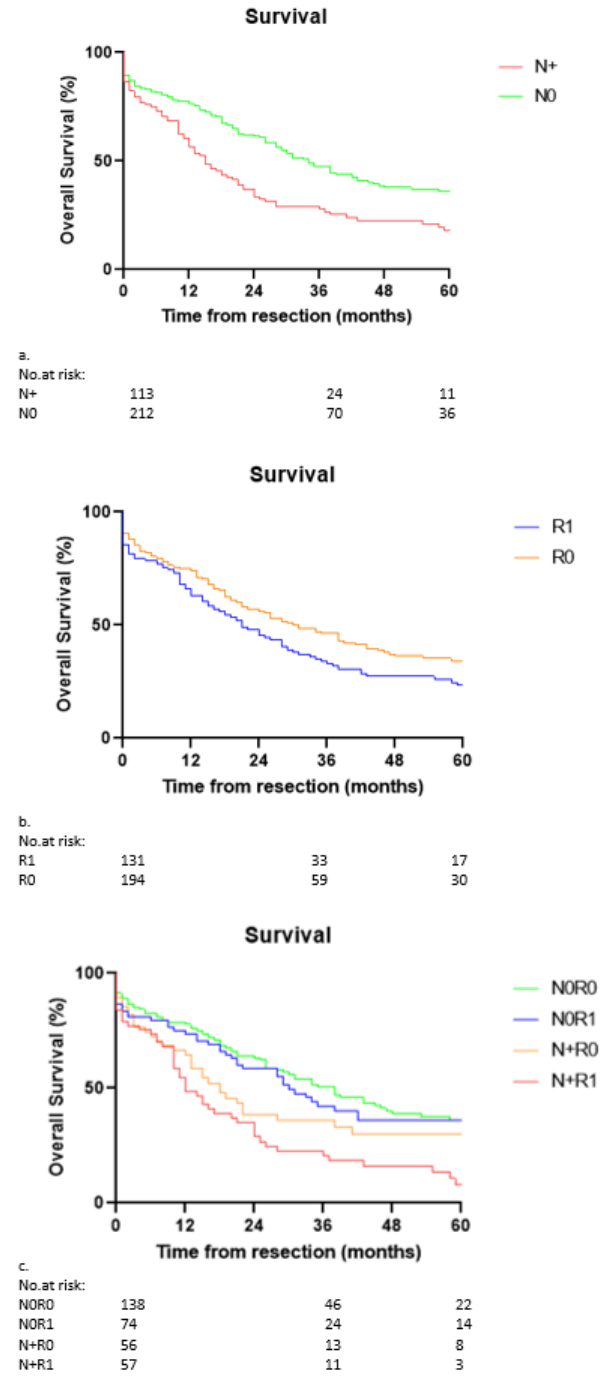
Figure 2. ( a ): Kaplan–Meier curve for overall survival and lymph node-negative (N0) and lymph node-positive (N+) patients. Only the first 5 years are displayed. Median OS was 34 months (95% CI 27.9–40.1) for the N0 versus 15 months (95% CI 10.6–19.4) for the N1 patients ( p < 0.001). ( b ): Kaplan–Meier curve for overall survival of resection margin-negative (R0) and resection margin- positive (R1) patients. Only the first 5 years are displayed. Median OS was 31 months (95% CI 23.0–39.0) for R0 versus 21 months (95% CI 14.9–27.2) for R1 patients ( p = 0.037). ( c ): Kaplan–Meier curve for overall survival of N0R0, N0R1, N+R0, and N+R1 patients. Only the first 5 years are displayed. Median OS was 38 months (95% CI 28.0–48.0) for N0R0, 30 months (95% CI 19.8–40.2) for N0R1, 18 months (95% CI 10.7–25.3) for N+R0, and 12 months (95% CI 7.7–16.3) for the N+R1 patients ( p < 0.001). N0R0 vs. N+R0: p = 0.064, N0R1 vs. N+R1: p < 0.001, N+R0 vs. N+R1: p = 0.061, N0R0 vs. N0R1: p =